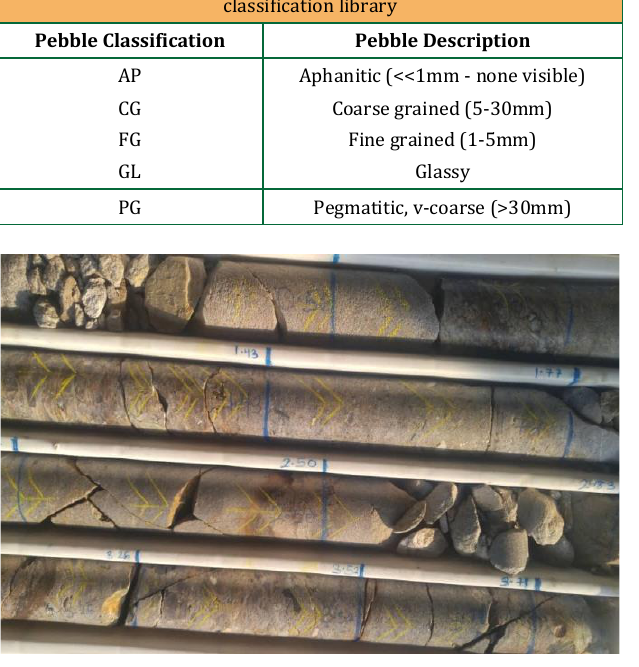
Figure 1: Clast-supported conglomerate from C-Pit